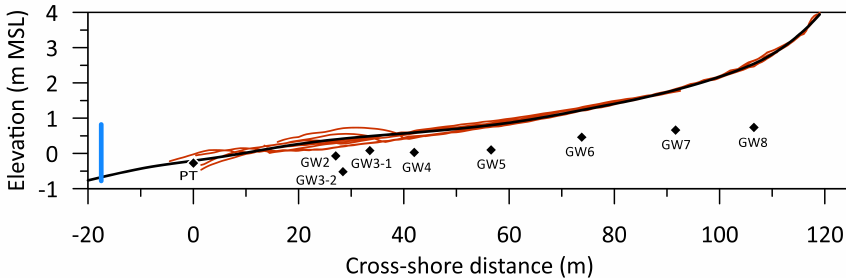
Figure 4. Bed elevation z versus cross-shore distance x on all moisture measurement days (six red-brown lines). The thick black line is the campaign-averaged cross-shore profile. Its extension seaward of x ≈ 0 m is based on a jet-ski survey of the subtidal zone performed on 3 November. Also shown are the locations of the pressure transducer (PT) and the groundwater wells that operated during at least part of the campaign. GW3-1 and GW3-2 are GW3 prior to 7 October and after 9 October, respectively. See text for further explanation. The blue vertical line indicates the mean tidal